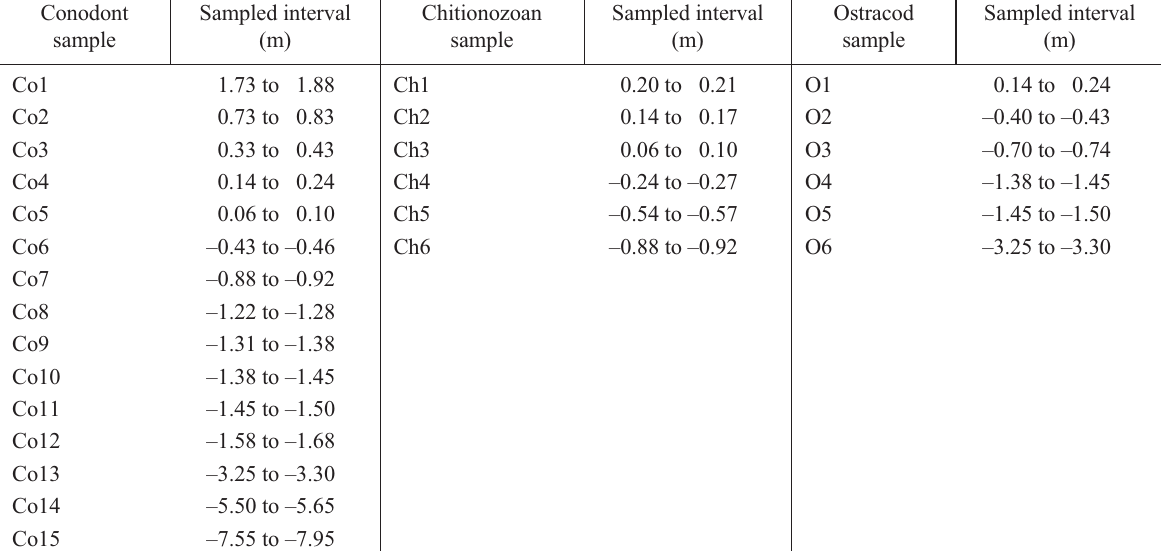
Table 1. List of samples from the Peetri composite section. Sample depths with respect to the top of a complex of discontinuity surfaces 0.1 m below the lower K­bentonite